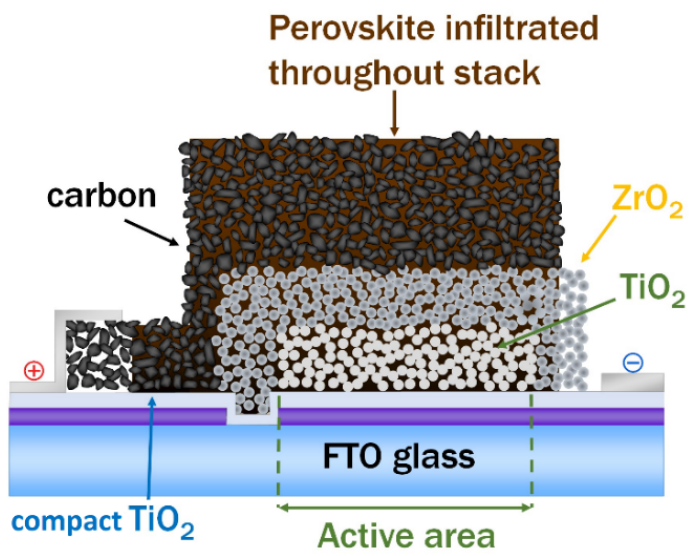
Figure 1. Schematic of a typical triple-mesoscopic carbon perovskite solar cell (mCPSC). The TiO 2 , ZrO 2 and carbon of the triple-mesoscopic stack are deposited sequentially before infiltration of the perovskite precursor solution. Adopted from reference [15] with permission from The Royal Society of Chemistry.